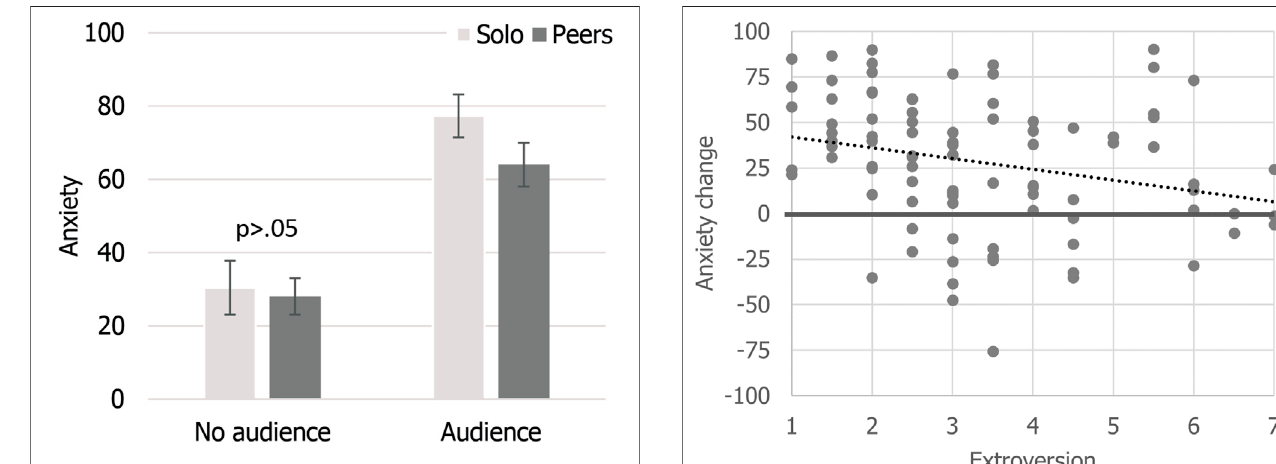
FIGURE 5 | 20% trimmed mean data for Anxiety data, split by Audience and Peer factors. 95% con fi dence intervals based on 20% trimmed data calculated via the trimci function of the r WRS package (Wilcox 2012; n.b. con fi dence intervals did not take into account the repeated measures nature of the design). All group trimmed means statistically differed from each other p < 0.05, unless otherwise stated.